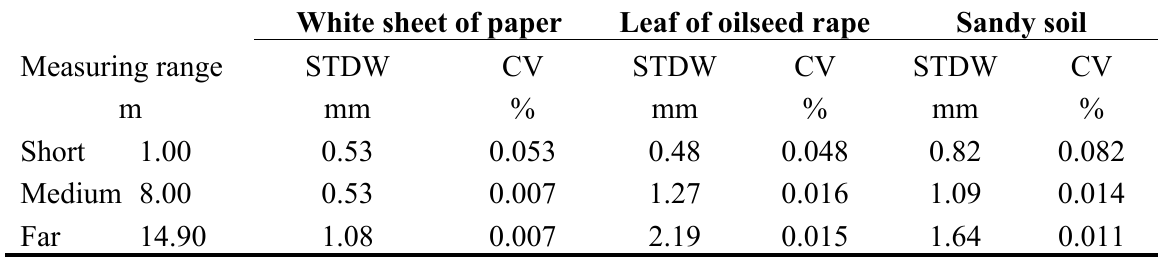
Table 3. Standard deviations (STDW) and coefficients of variation (CV) for immobile target